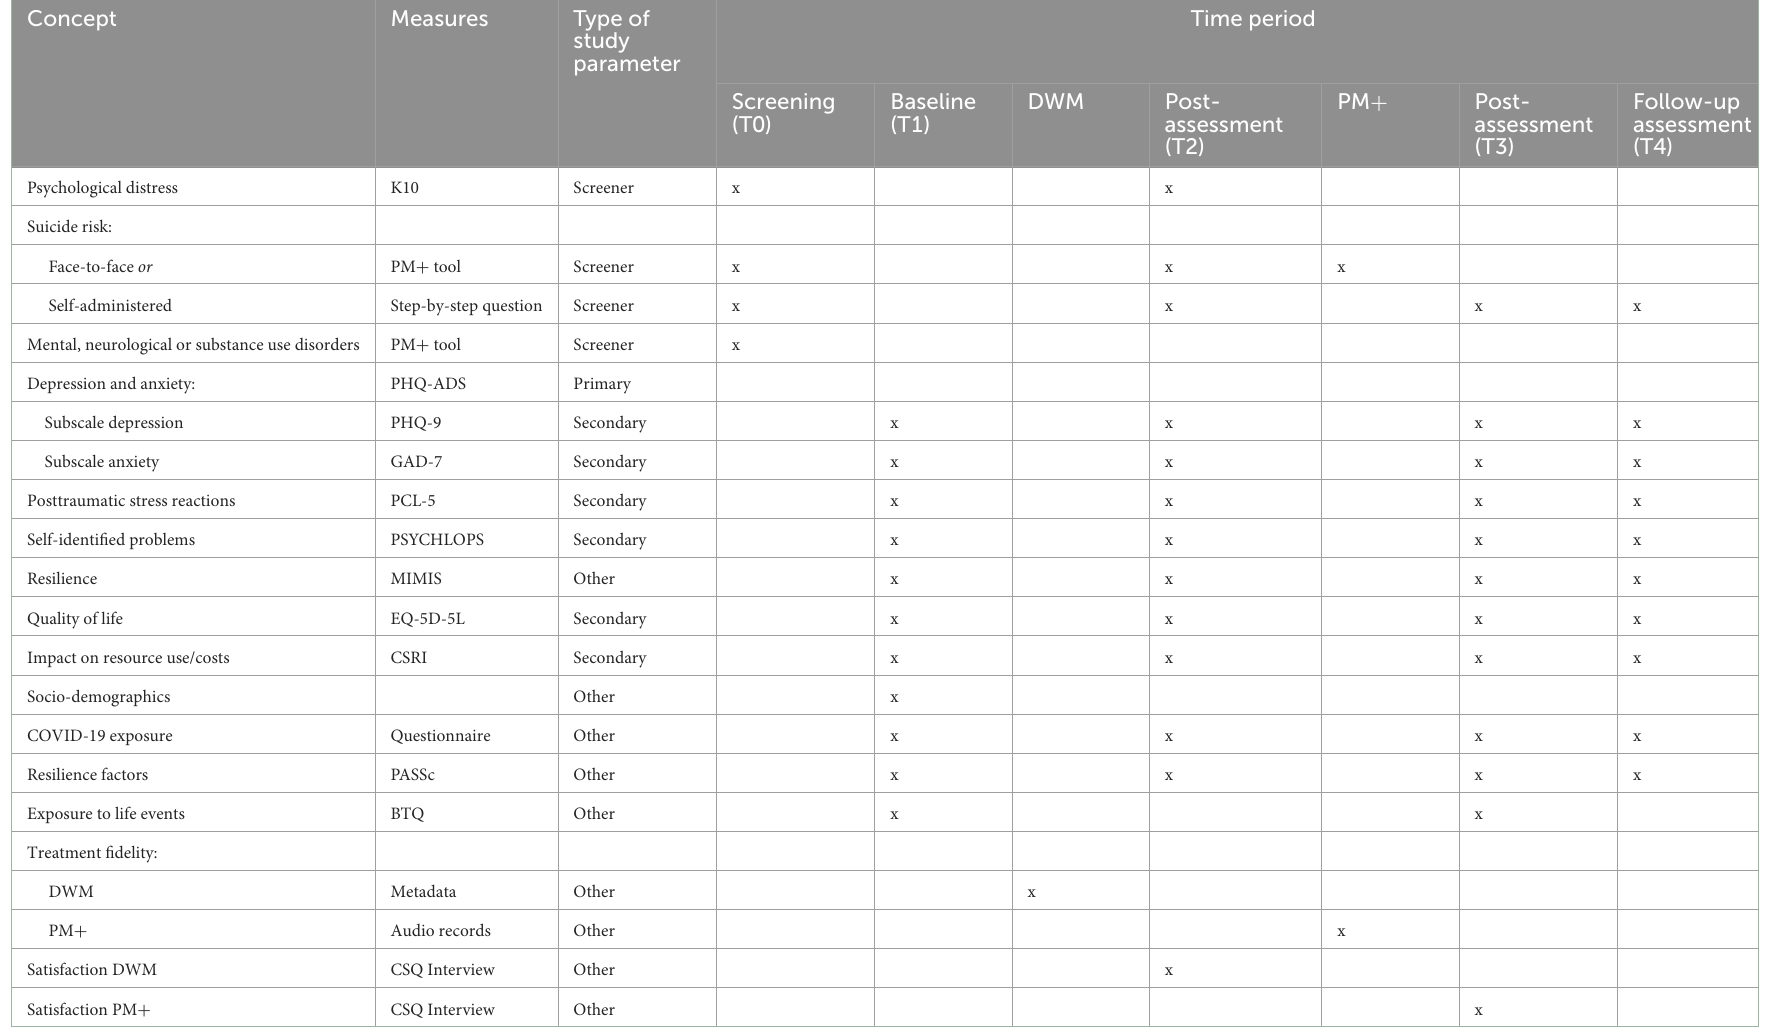
TABLE 1 Overview of concepts, measures, type of study parameter and time periods when they are